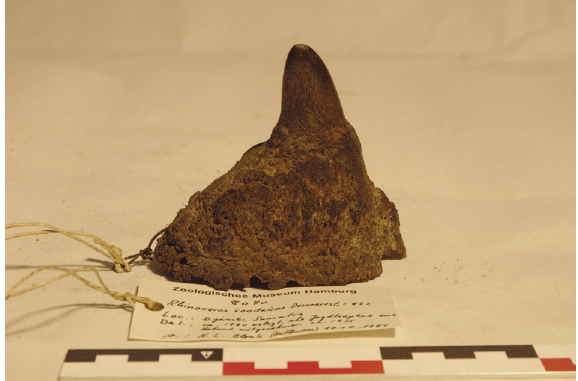
Figure 2. The specimens ZMH S 8070 of the Zoological Mu- seum Hamburg, labelled as “ Rhinoceros sondaicus Demarest, 1822”, with location given as Djambi, Sumatra. [photograph courtesy of Thomas